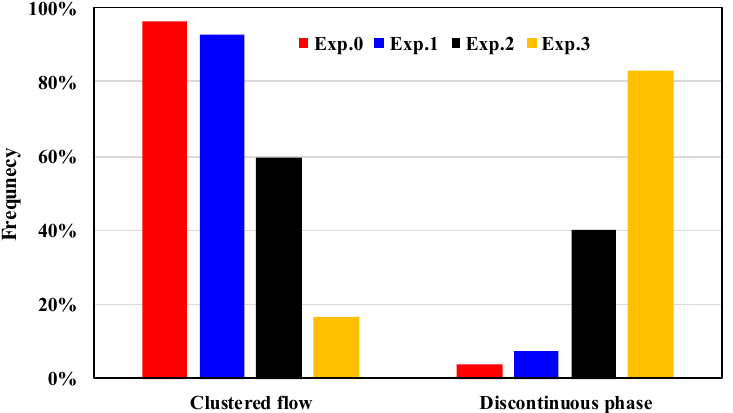
Figure 15. The distribution frequency of the cluster flow and discontinuous phase in different stages.